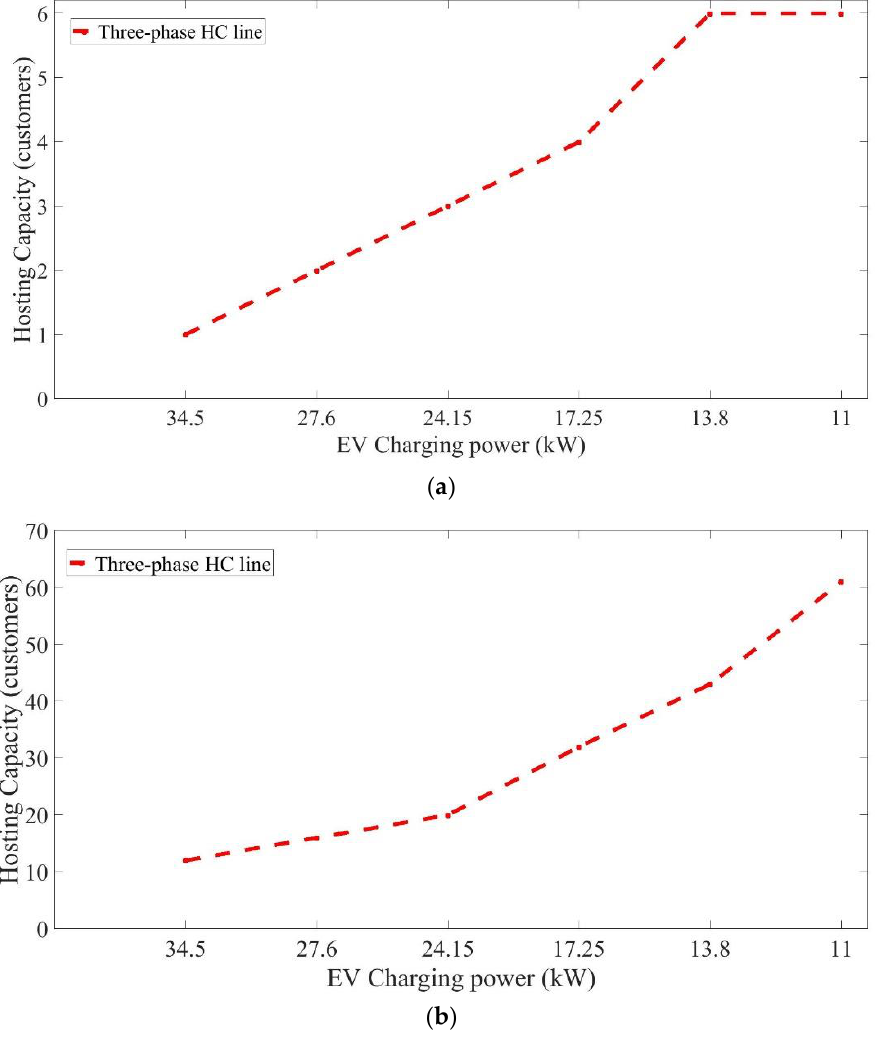
Figure 7. Three-phase hosting capacity results for 11, 13.8, 17.25, 24.15, 27.6 and 34.5 kW: ( a ) 6-customers distribution network; ( b ) 83-customers distribution network.